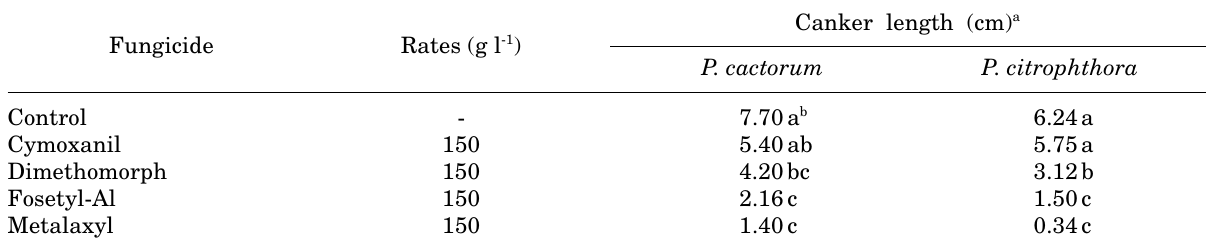
Table 5. Canker length of metalaxyl, fosetyl-Al, dimethomorph, and cymoxanil painted on scraped stem cankers